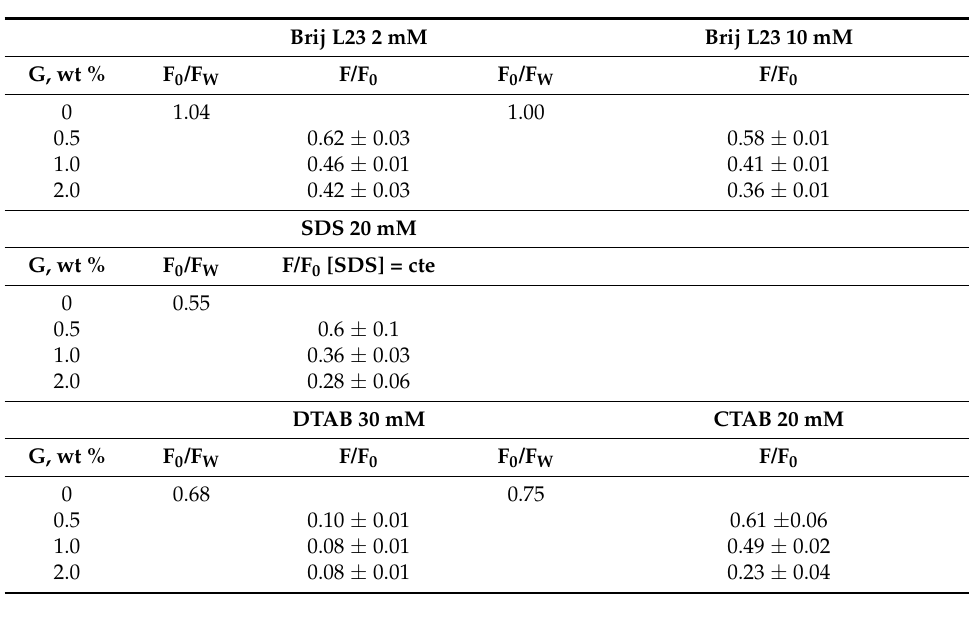
Table 1. Fluorescence ratios of riboflavin in the G dispersions and in the surfactant solutions. (F/F 0 : ratio of the fluorescence in G dispersions in the surfactant solutions (F) to the fluorescence in the surfactant solutions (F 0 ); F 0 /F W : ratio of the fluorescence in the surfactant solutions to the fluorescence in water, F W